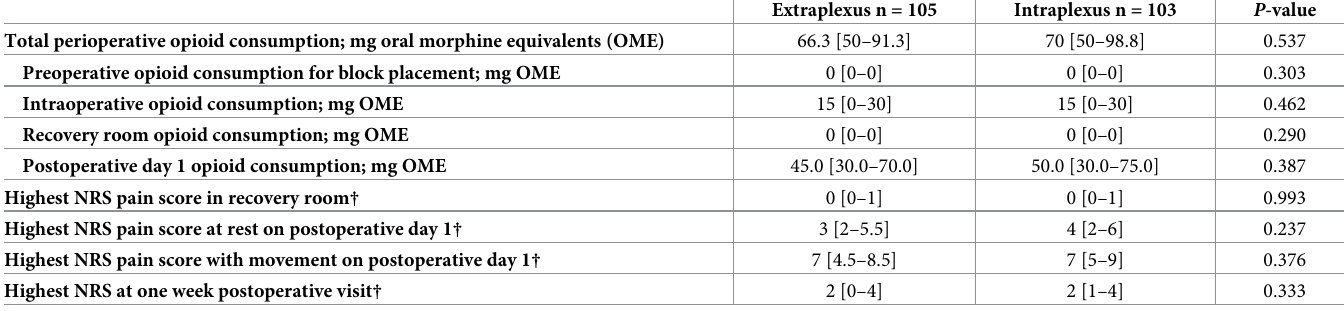
Table 4. Pain scores and opioid consumption